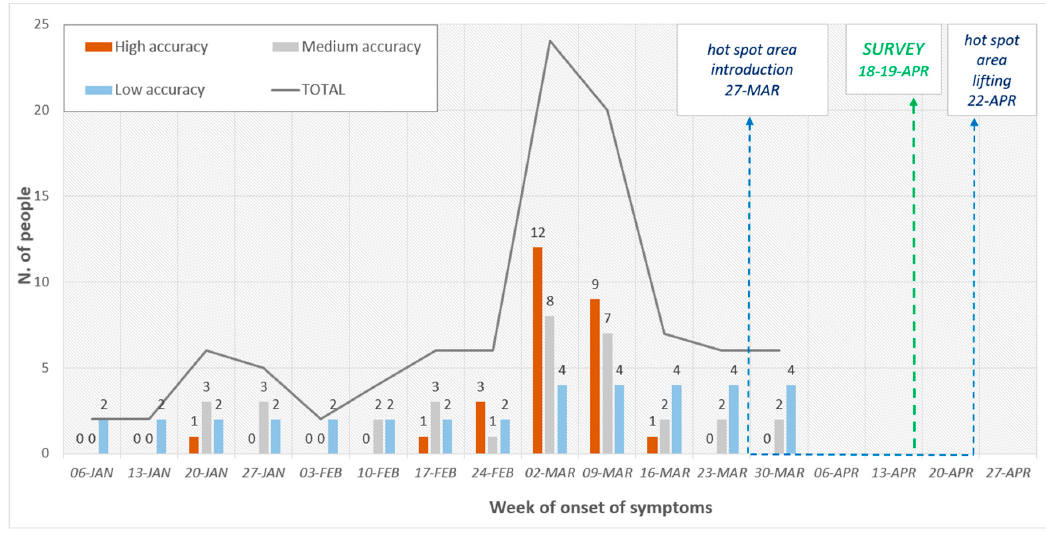
Figure 2. Week of onset of symptoms per accuracy of the information.